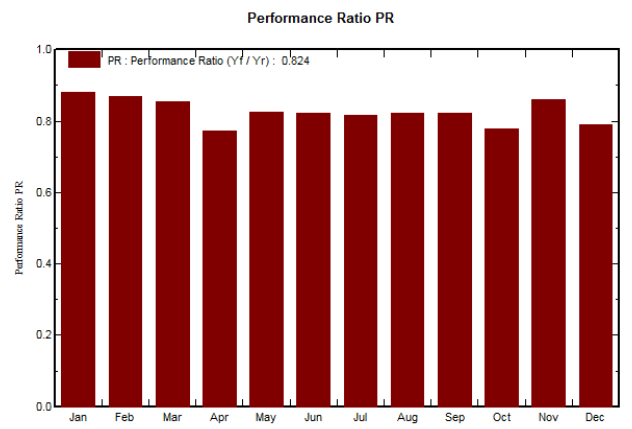
Figure 8. Loss diagram of PV power station